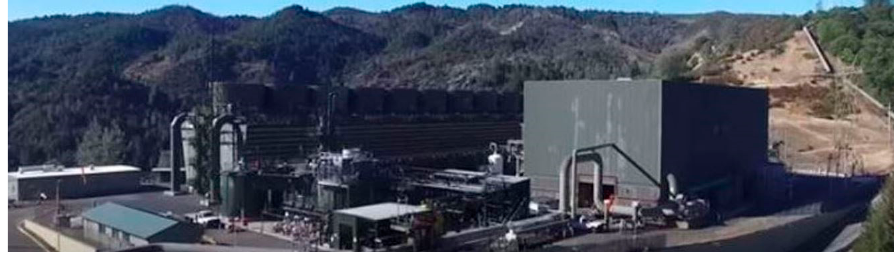
Figure 26. The Geysers geothermal field in California [64].